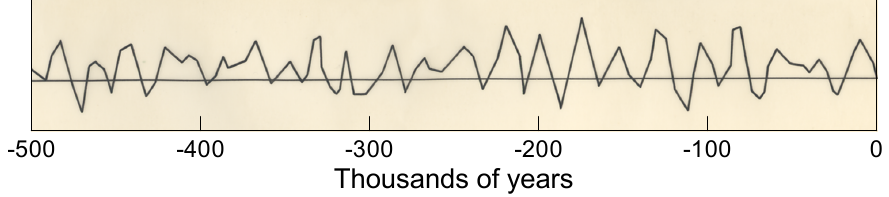
Fig. 4. Insolation curve of the Earth (arbitrary caloric units, some of the minima correspond to glacial periods). Based on Sterken